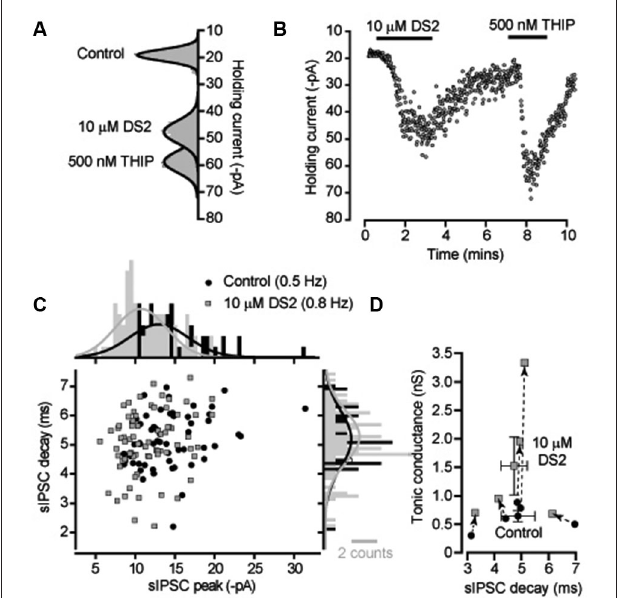
FIGURE 1 | DS2 application to cerebellar granule cells enhances the tonic conductance but does not alter IPSC properties . (A) All-point histograms were constructed from 100 ms current traces (V H − 60 mV) recorded from a cerebellar granule cell in control conditions and in the presence of 10 µ M DS2 and 500 nM THIP and the solid lines are Gaussian fits to the distributions. (B) The time course plot illustrates the change in average holding current calculated every 1 s from consecutive 100 ms current epoch. An enhancement of the tonic conductance was observed during DS2 and THIP applications. (C) Scatter plot of peak amplitude against decay time for all IPSCs recorded from this granule cell in the presence (filled squares, grey) and absence (filled circles, black) of DS2. The histograms on each axis illustrate Gaussian fits to the distributions constructed in the presence and absence of DS2. (D) Scatter plot of the average tonic conductance and average sIPSC decay before and after DS2 application. The data for individual cells are linked by dashed lines and arrows to illustrate the consistent increase in the tonic conductance that takes place with no consistent change in the IPSC decay. Superimposed on this plot are the average values across all cells (mean ± SEM, n =